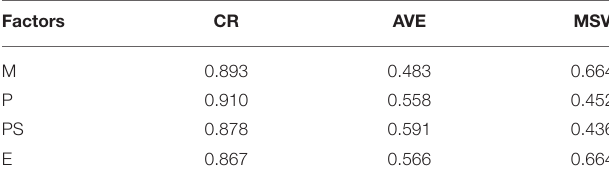
TABLE 4 | Validity and reliability of Model D.